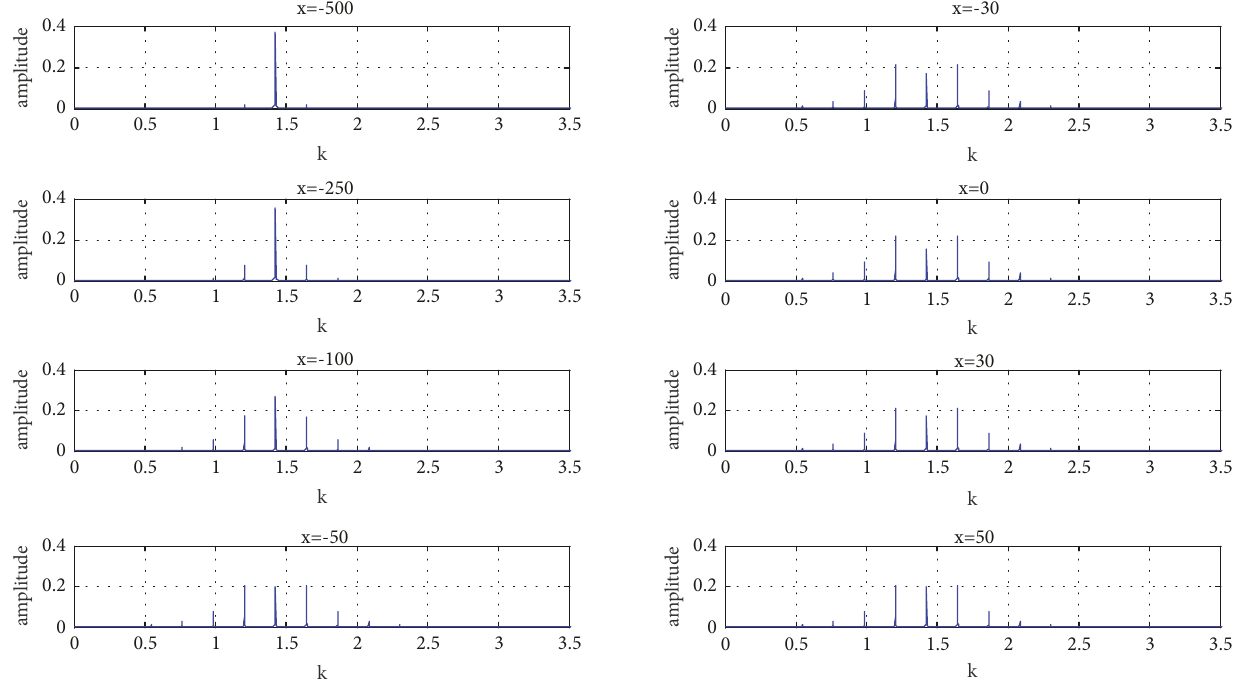
;̃𝑘;̂ ] ) = (0.2; 0.9186; 1) 0